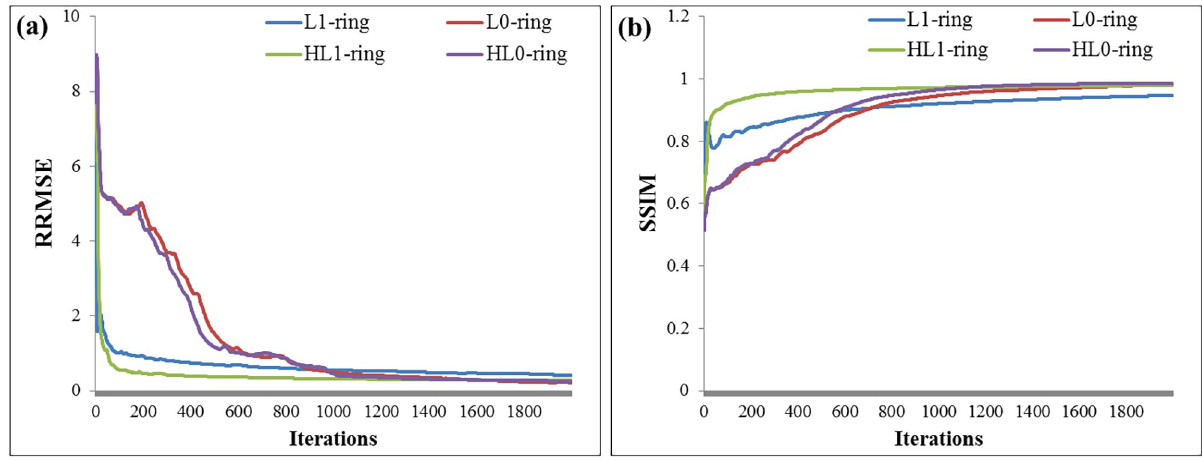
Fig 8. Computed (a) RRMSE and (b) SSIM values versus the iteration numbers for the third study case.